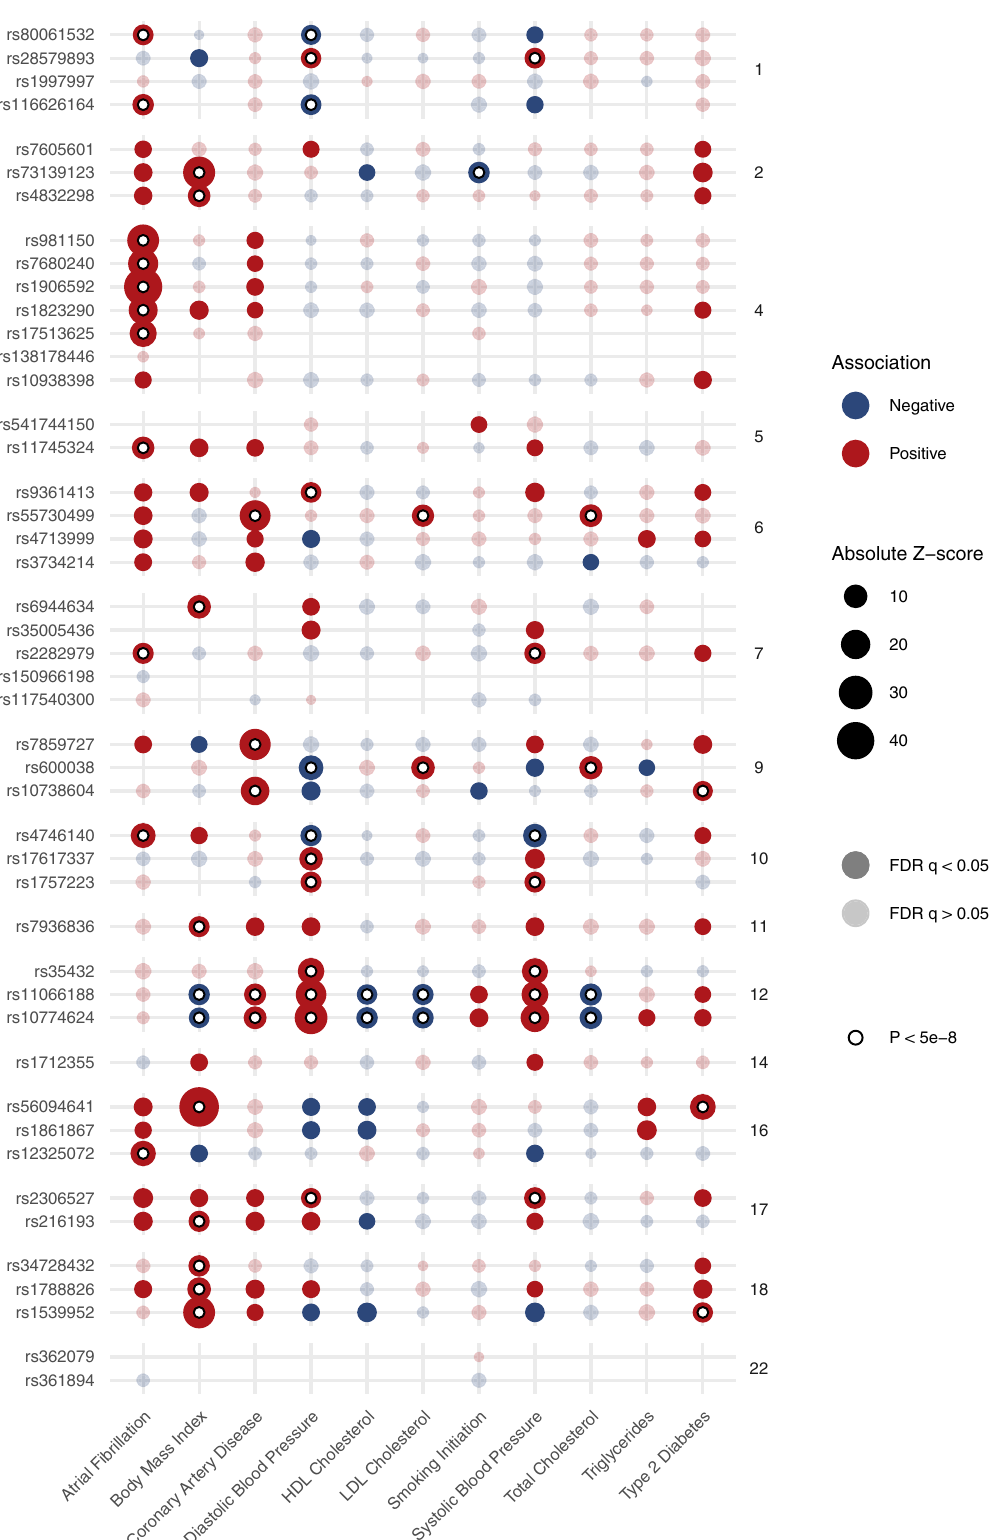
GWAS. The size of each point denotes the absolute z-score for each trait, with reference to the heart-failure increasing allele. The shading of each point denotes whether the association met an FDR adjustment for multiple testing. Associations exceeding the conventional genome-wide signi fi cance threshold are denoted with a white circle. Variants are grouped by chromosome. FDR false discovery